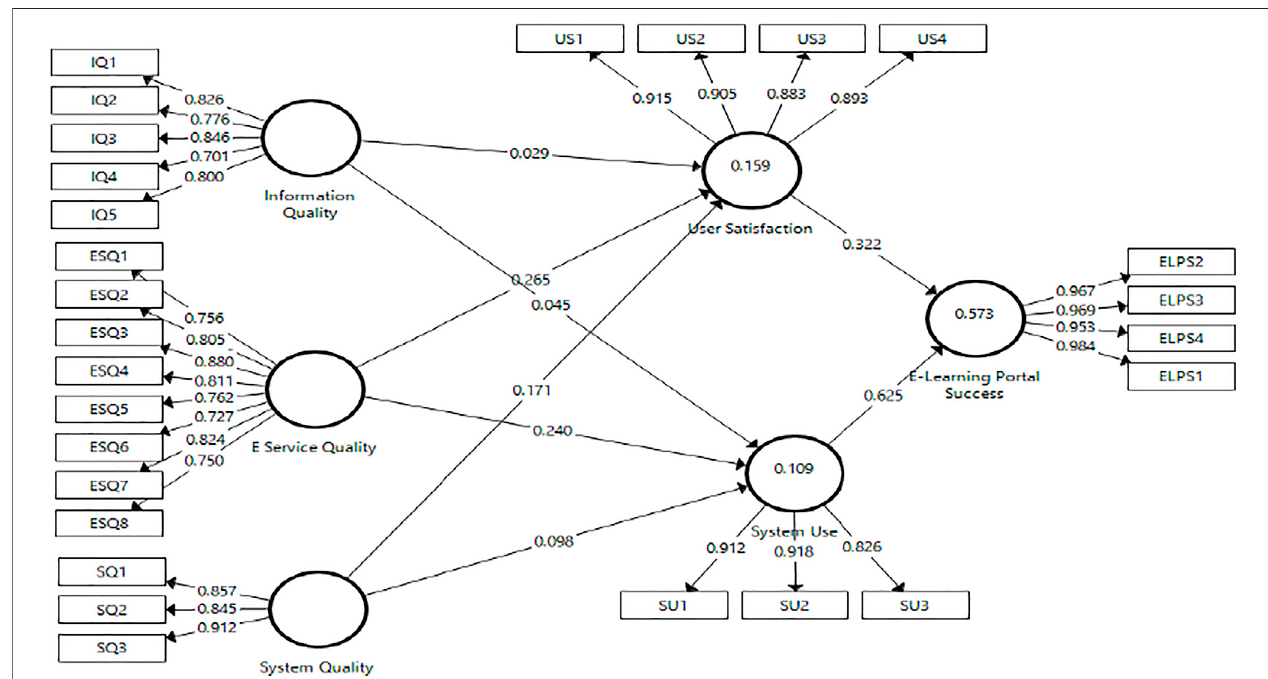
FIGURE 3 | Full measurement model.